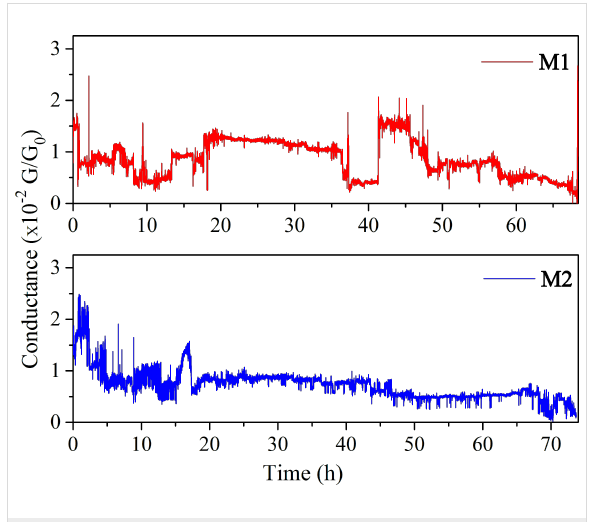
Figure 5: Conductance versus time at values close to the maxima of Figure 4 at room temperature for M1 (upper panel) and M2 (lower